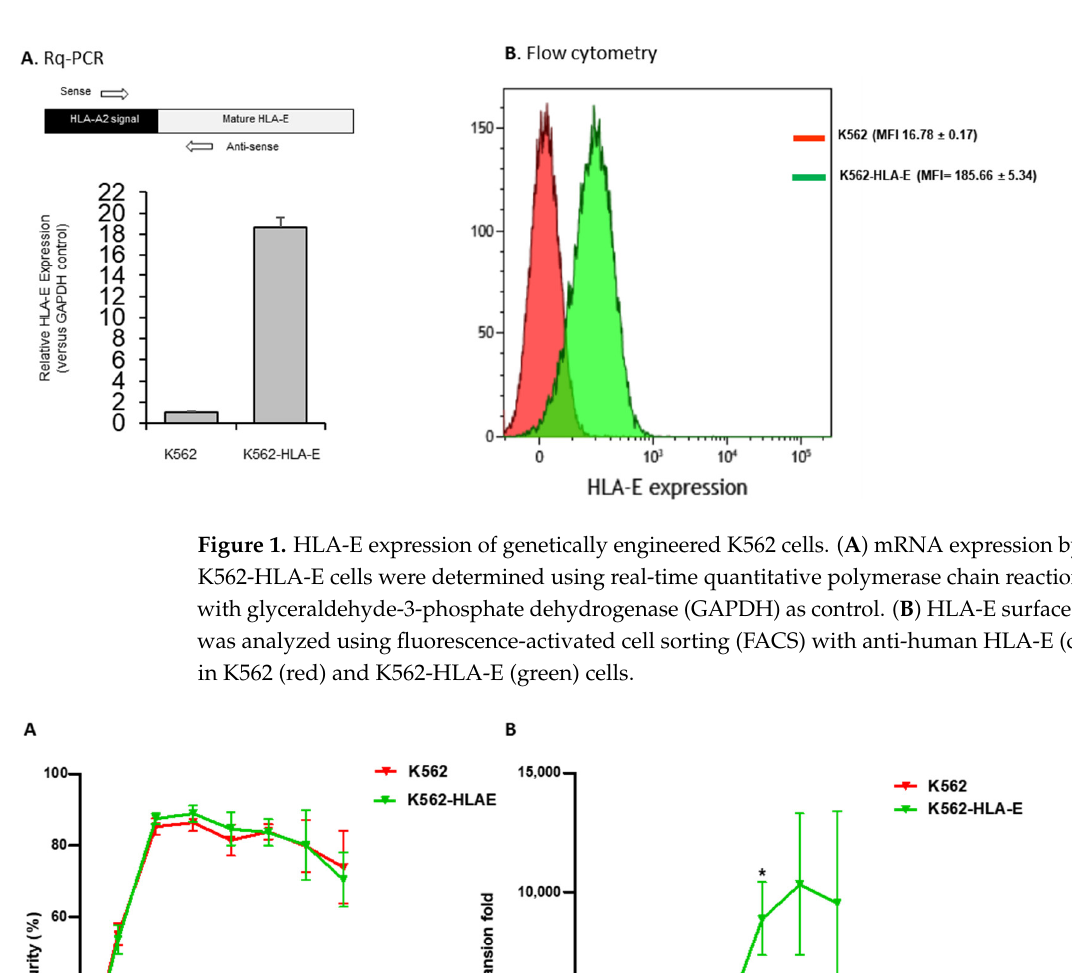
Figure 1. HLA-E expression of genetically engineered K562 cells. ( A ) mRNA expression by K562 and K562-HLA-E cells were determined using real-time quantitative polymerase chain reaction (Rq- PCR) with glyceraldehyde-3-phosphate dehydrogenase (GAPDH) as control. ( B ) HLA-E surface ex- pression was analyzed using fluorescence-activated cell sorting (FACS) with anti-human HLA-E (clone 3D12) in K562 (red) and K562-HLA-E (green) cells.